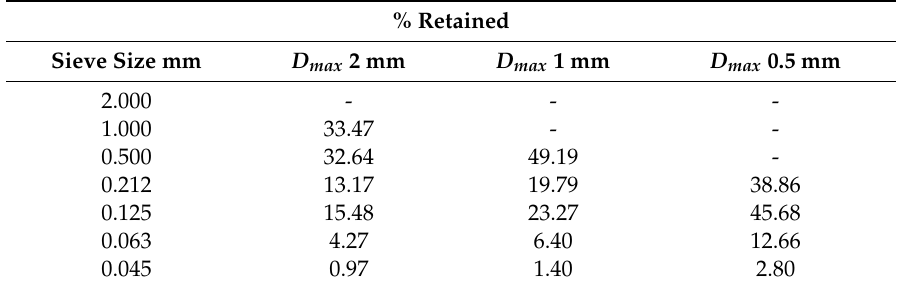
Figure 1. Image of aggregates ( a ) siliceous (S), ( b ) limestone (L), and ( c ) recycled aggregates (R) in fractions of maximum size 1 mm. Table 3. Particle size distribution of the S aggregate after di ff erential sieving ( D max is the maximum diameter of the